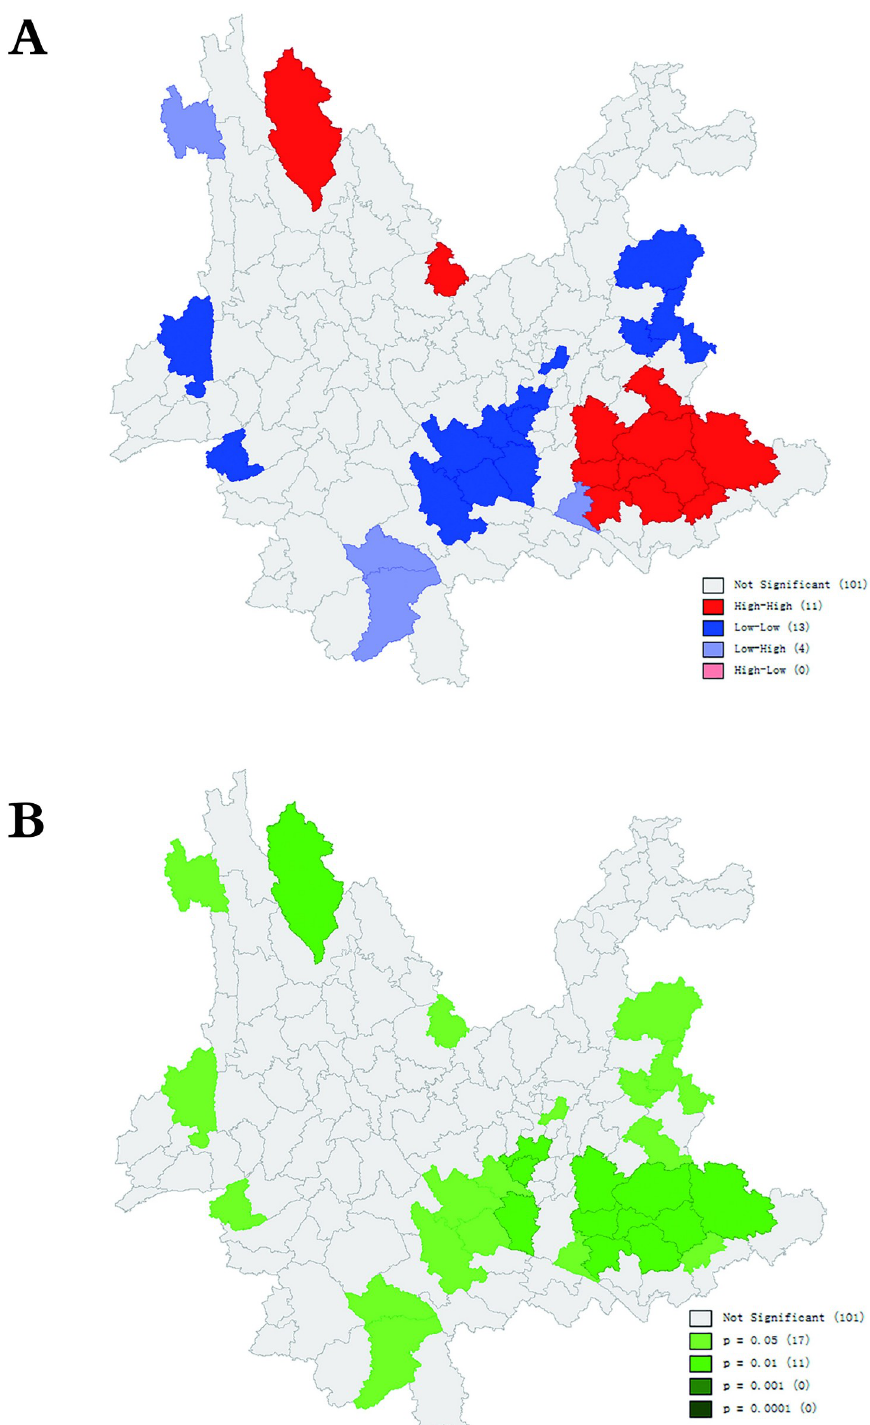
Fig 3. Local Spatial Autocorrelation of Newly Detected Leprosy Cases in Yunnan, China, 2011–2020. The base layer is from